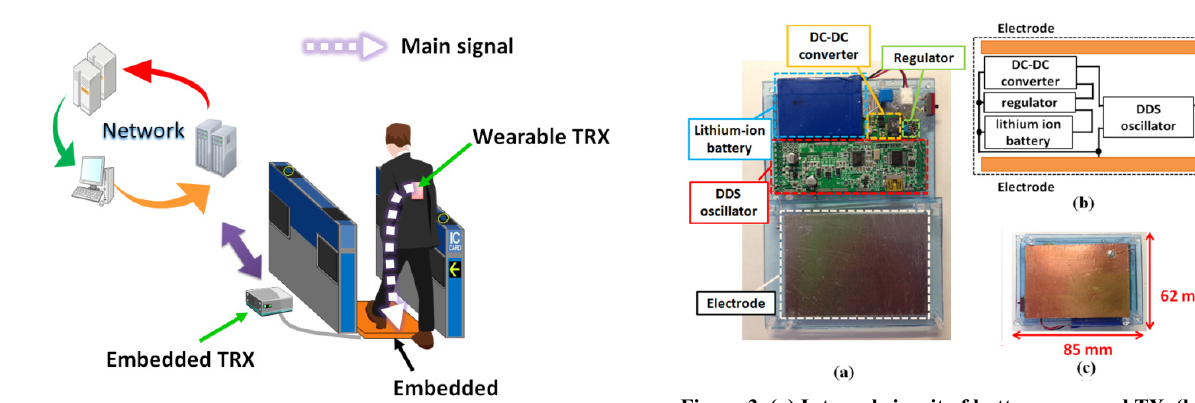
Figure 3. (a) Internal circuit of battery-powered TX, (b) block diagram of battery-powered TX, and (c) external shape of wearable TRX.